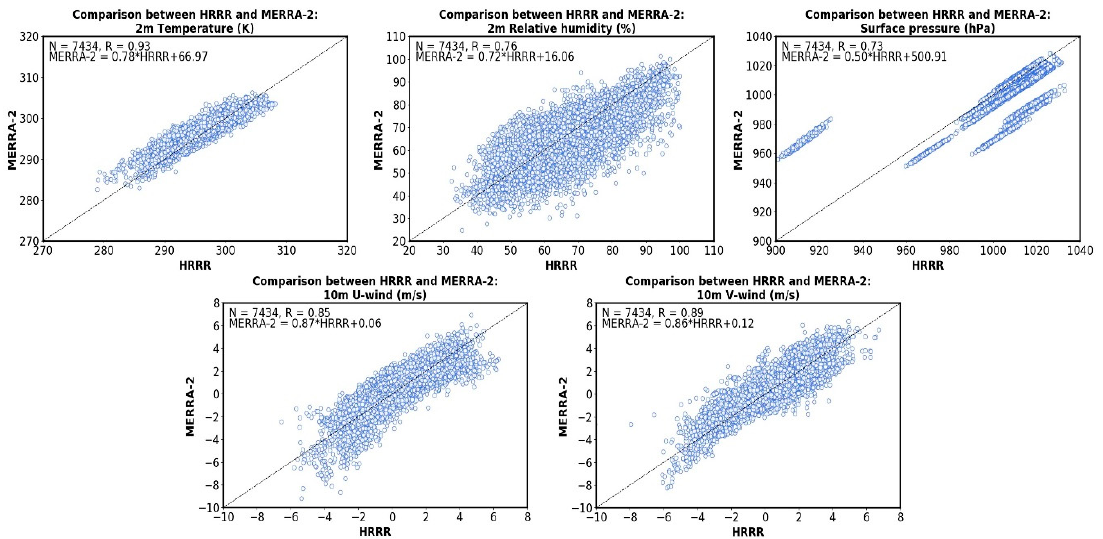
Figure A1. Comparison between HRRR and MERRA-2 meteorological fields.